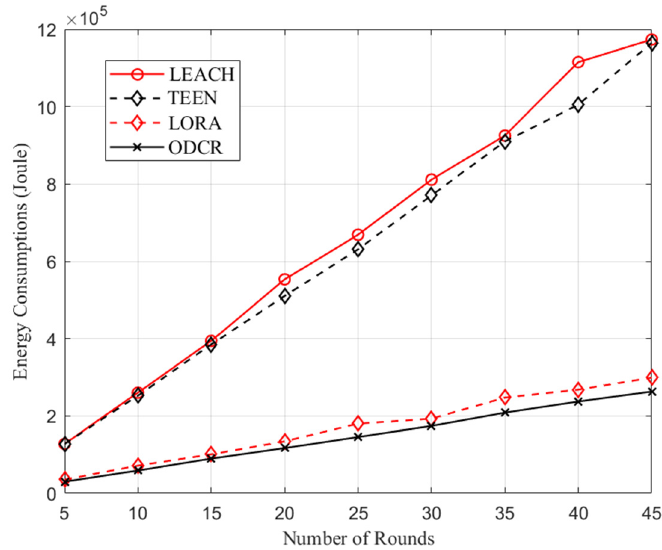
Figure 8. Comparison of energy consumption .